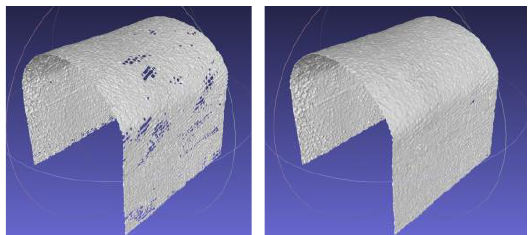
Figure 12 . Illustration of the effect of grid optimisation